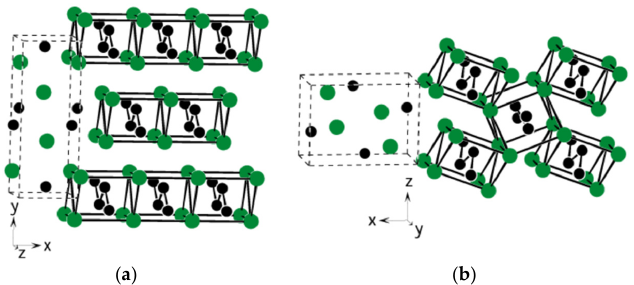
Figure 1. ( a ) CrB- and ( b ) FeB-type structures. Green and black circles represent the RE and Ni atoms, respectively. Both structures are composed of trigonal prisms containing four RE and four Ni atoms. While the RE atoms form a HCP stacking, the Ni atoms form a zigzag chain in both cases. Reprinted from [48].